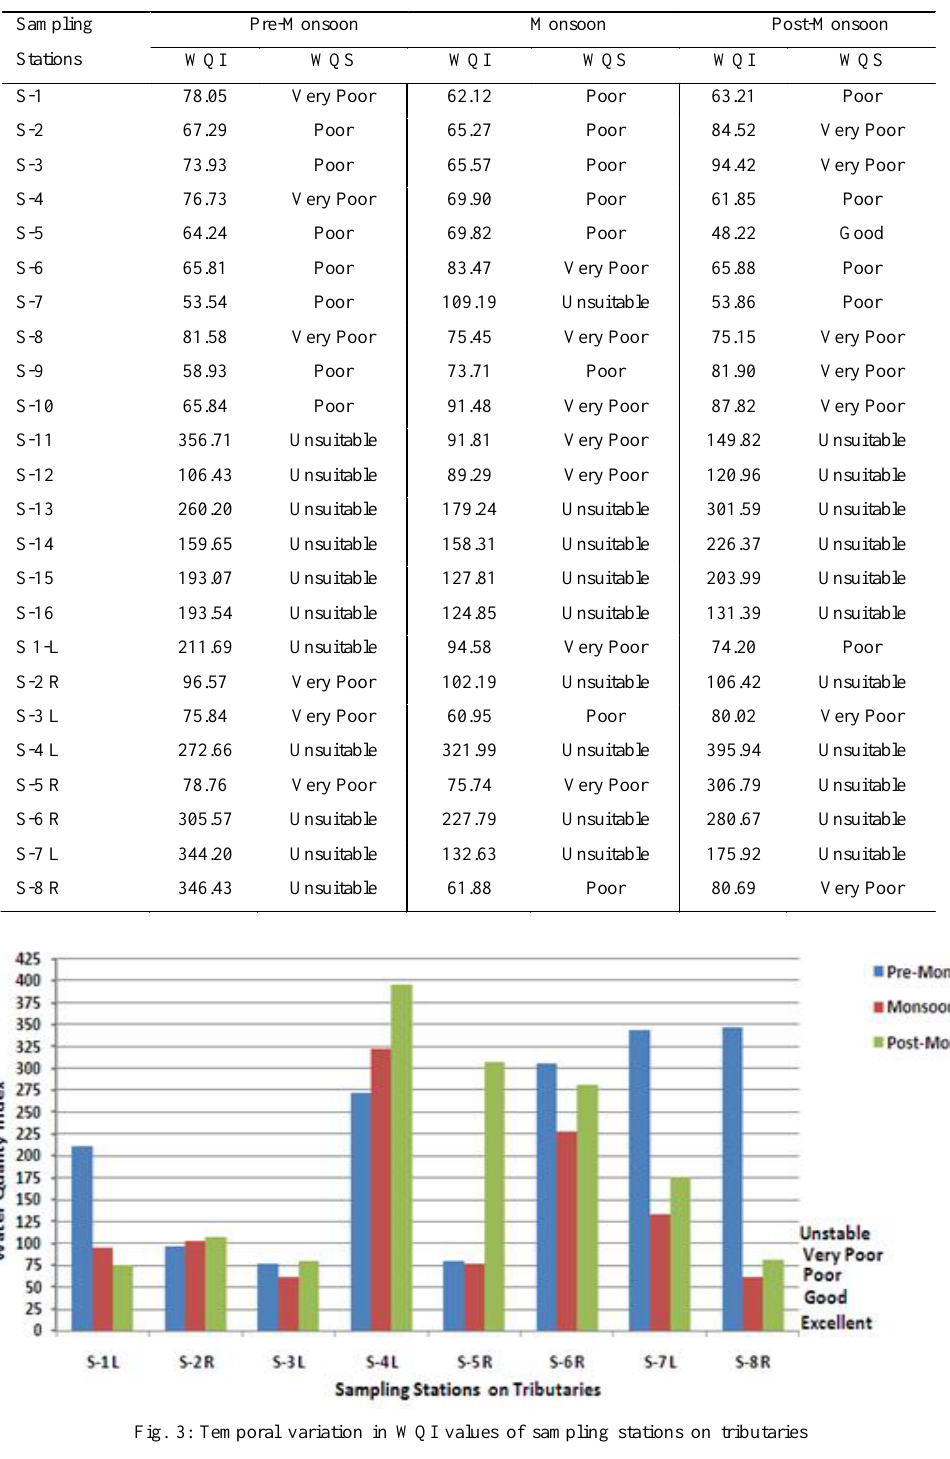
Fig. 3: Temporal variation in WQI values of sampling stations on